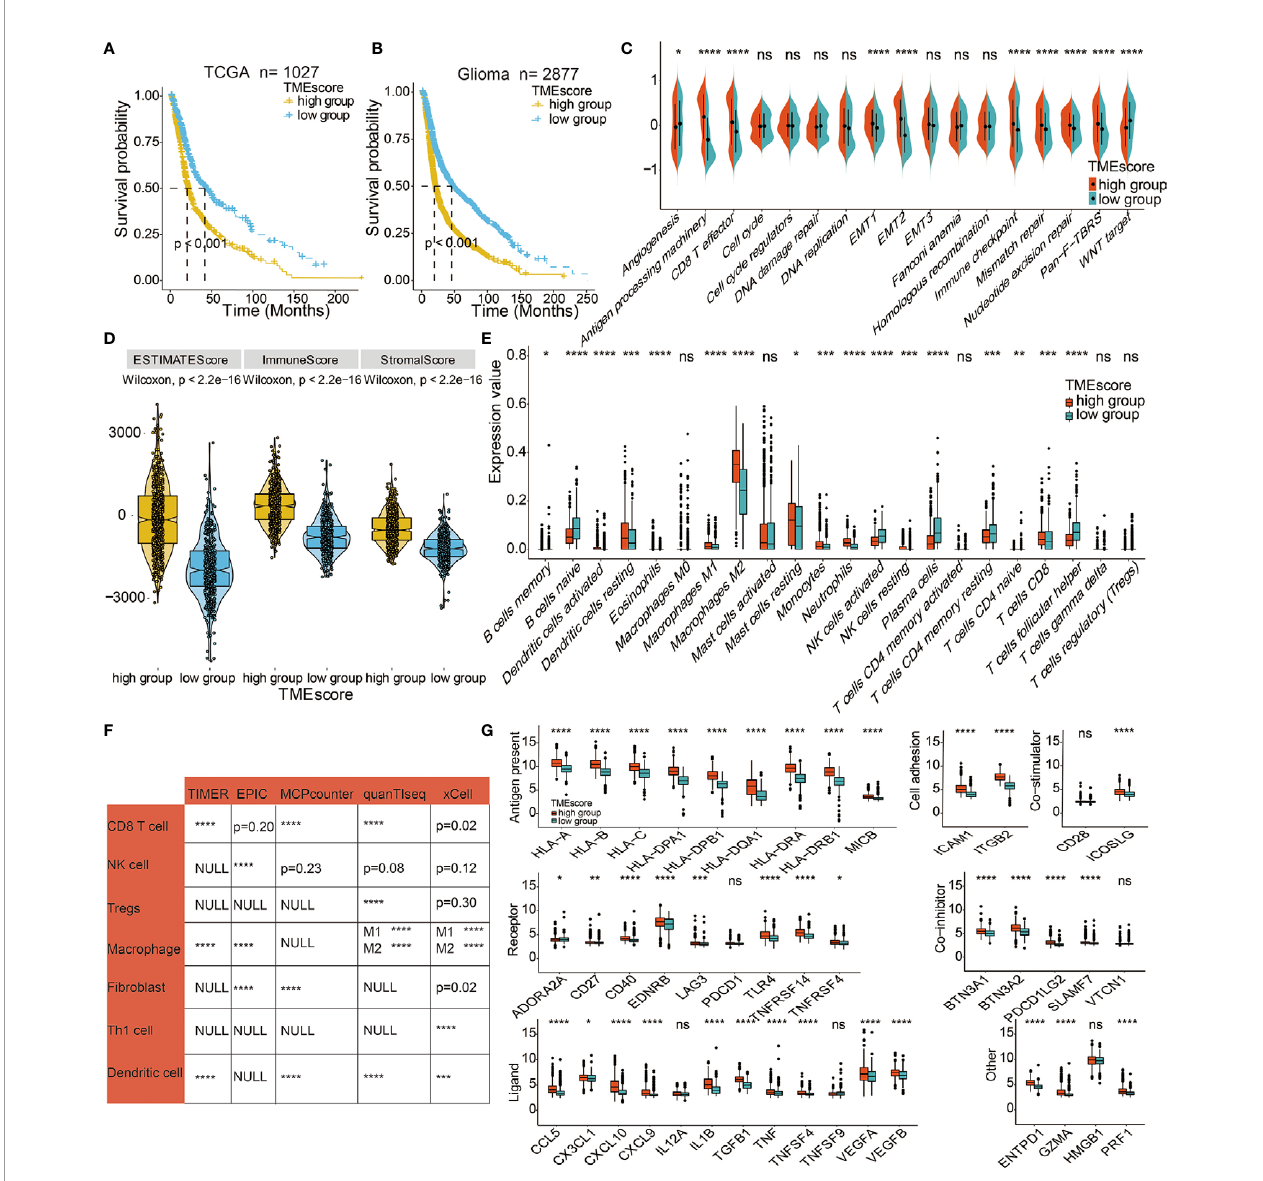
FIGURE 3 | Immune-related characteristics of the TME score. (A) Kaplan – Meier curves for high and low TME-score patient groups in TCGA. Log-rank test, P < 0.001. (B) Kaplan – Meier curves for the high and low TME-score patient groups in the meta-cohort. Log-rank test, P < 0.001. (C) TME-score patient groups were distinguished by different known signatures (immune, mismatch, and stromal signatures as indicated) in TCGA. The scattered dots represent the mean value of signature genes within each group. (D) Expression difference of Estimate Score, Immune Score, and Stromal Score in TME-score in TCGA. (E) Fraction of TME cells in TME-score in TCGA. Scattered dots represent TME cell expression values. (F) Correlation between TME-score and TME cells calculated by different algorithms in TCGA. (G) Fraction of seven types of immune checkpoints in TME-score in TCGA. Scattered dots represent immune checkpoint expression values. NS, Not Statistically Signi fi cant; *P < 0.05; **P < 0.01; ***P < 0.001; ****P <